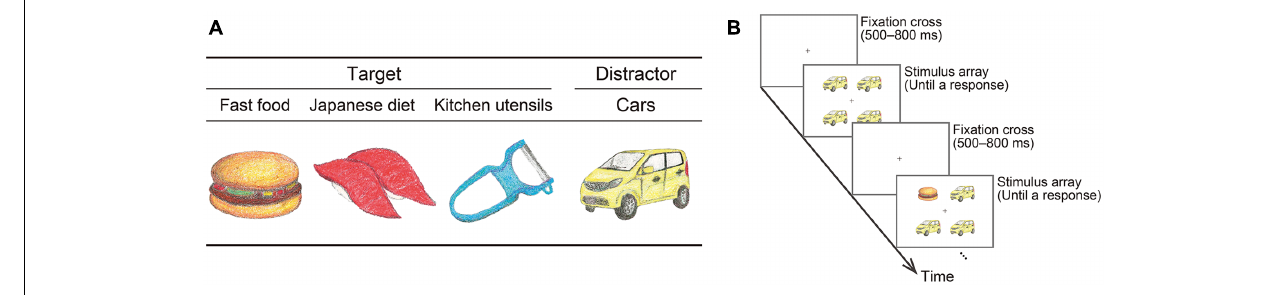
FIGURE 1 | Schematic illustration of stimuli (A) and visual search task (B) . Actual stimuli were full-color photographs. The examples of fast food, Japanese diet items, and kitchen utensils consist of a hamburger, sushi, and a peeler,